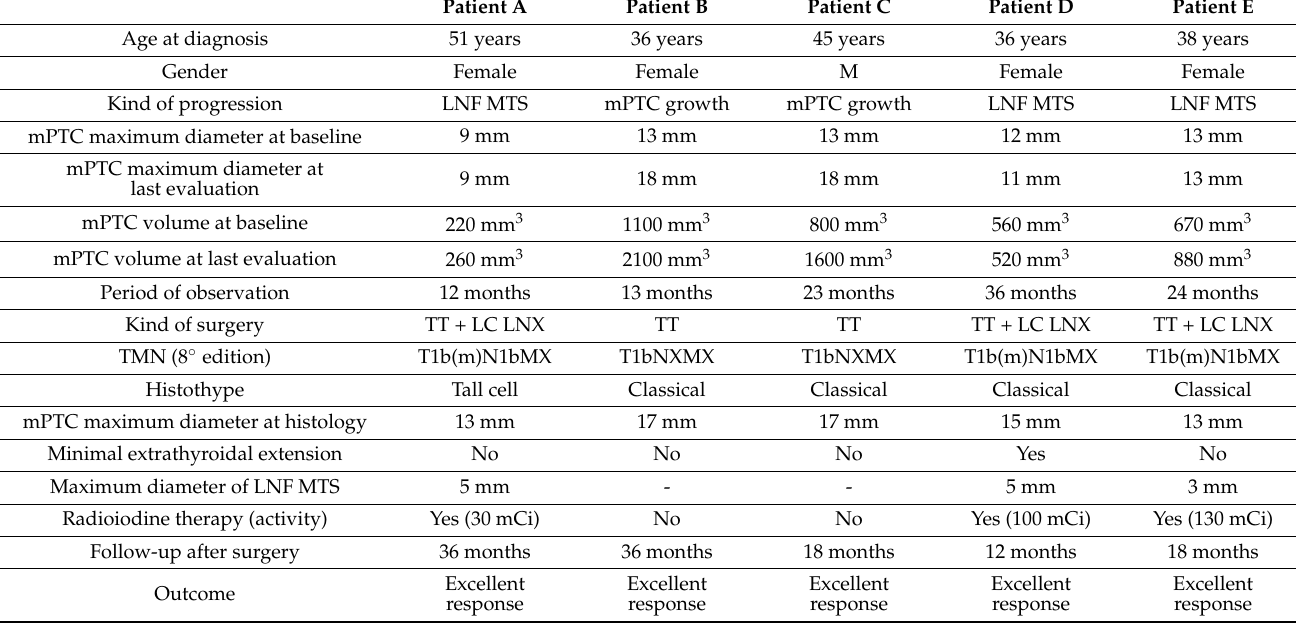
Table 1. Epidemiological, clinical and pathological features of progressing